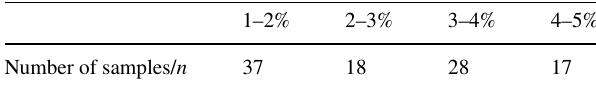
Table 4 The porosity distribution of samples